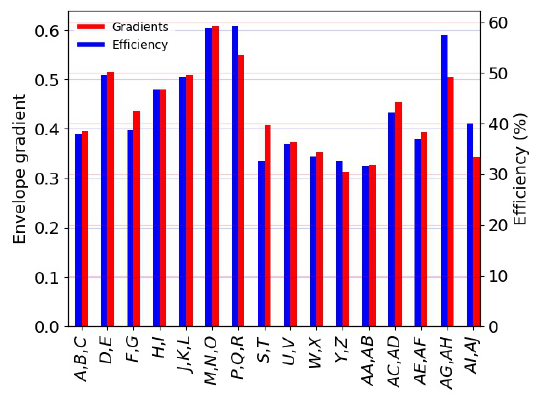
Figure 8. Envelope gradient and efficiency parameter for the investigated materials.